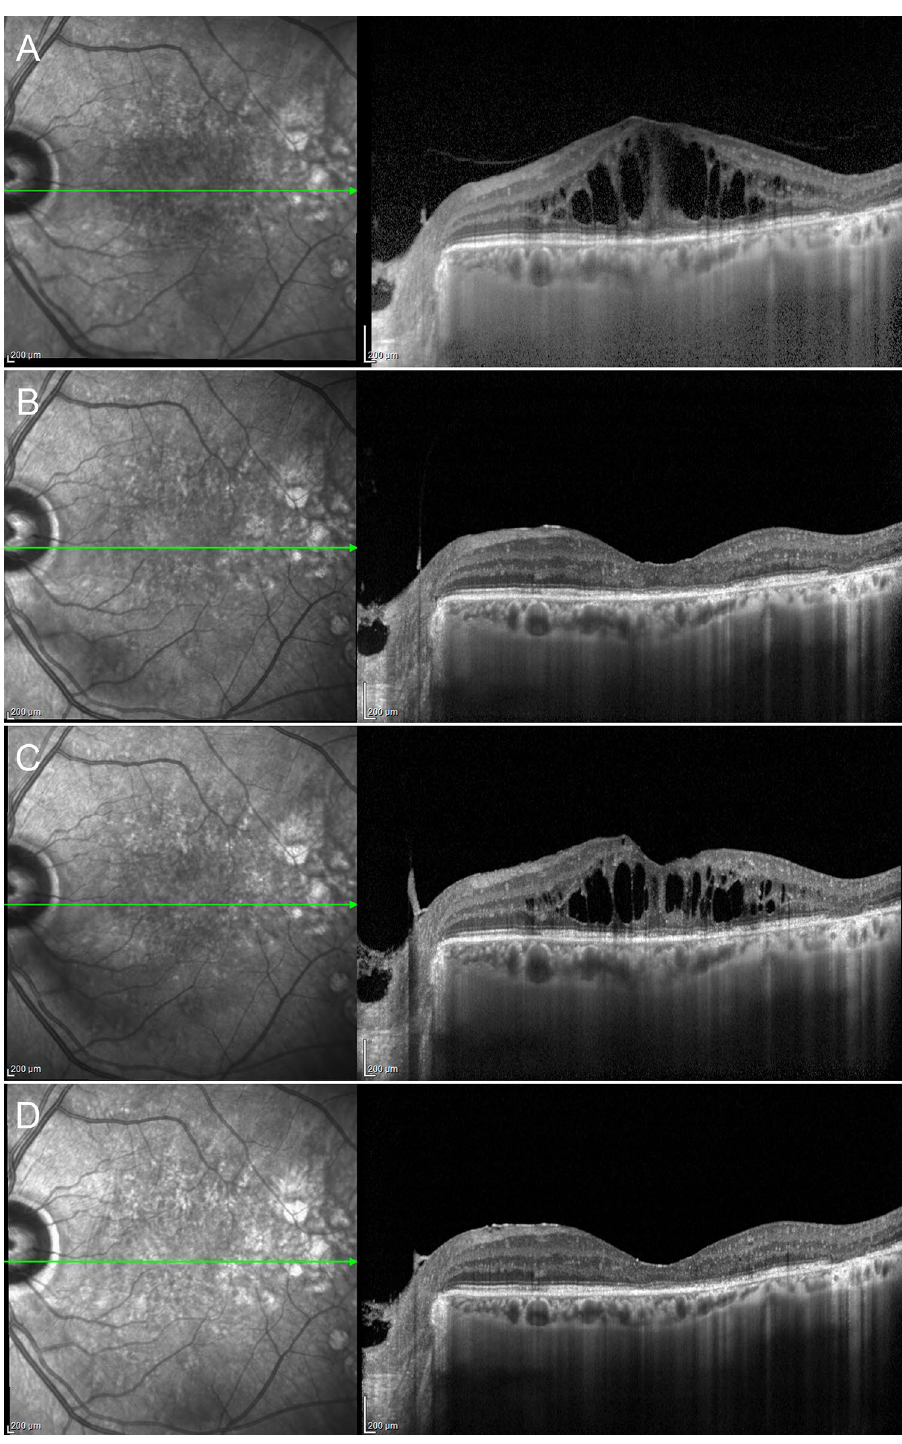
Figure 2. Foveal eversion Pattern 1a. The baseline condition is characterized by a DME with everted foveal profile and a central column of transretinal mixed reflectivity material ( A ). This case displays recurrent behavior, with complete regression of the intraretinal fluid ( B ) (6-month F/U) and further reappearance with preserved central columnar organization ( C ) (9-month F/U). At the last follow-up, DME has been completely reabsorbed and the ellipsoid zone is in good condition, despite a thinning of the outer nuclear layer ( D